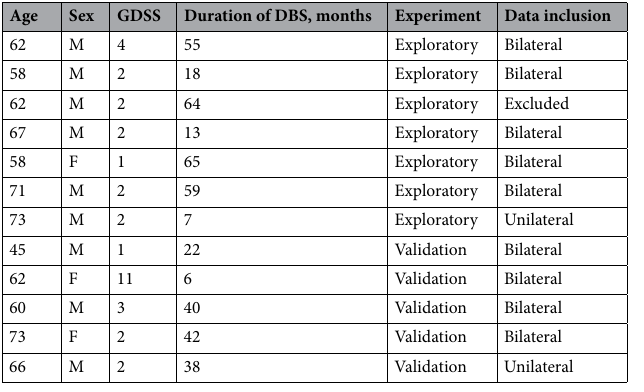
Table 1. Subject characteristics. GDSS Geriatric Depression Scale Short Form score. Duration of DBS measured from time of implant to time of study.